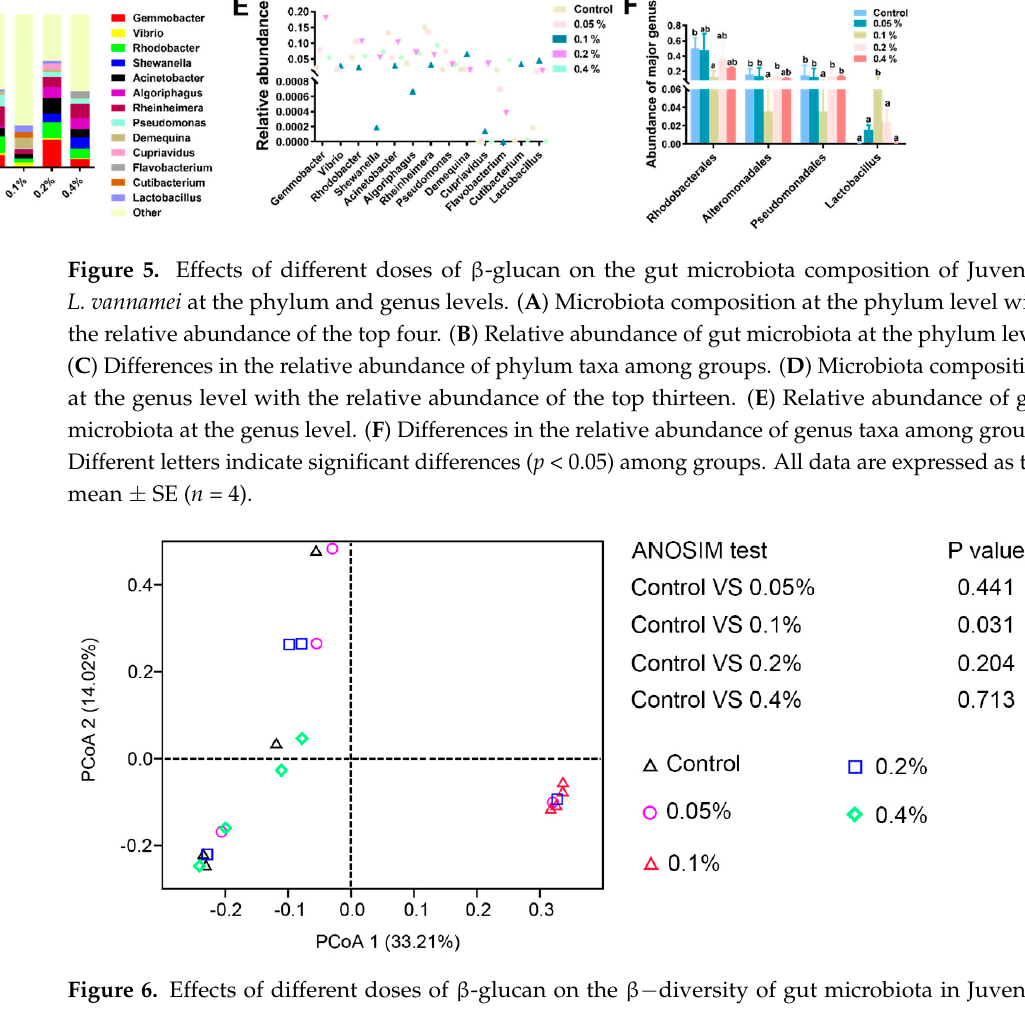
Figure 6. Effects of different doses of β -glucan on the β − diversity of gut microbiota in Juvenile L. vannamei . PCoA of the microbiota at the OTU level based on Jaccard distances. Analysis of similarity (ANOSIM) was performed to evaluate the overall differences in bacterial community structure based on Jaccard distance ( n = 4).